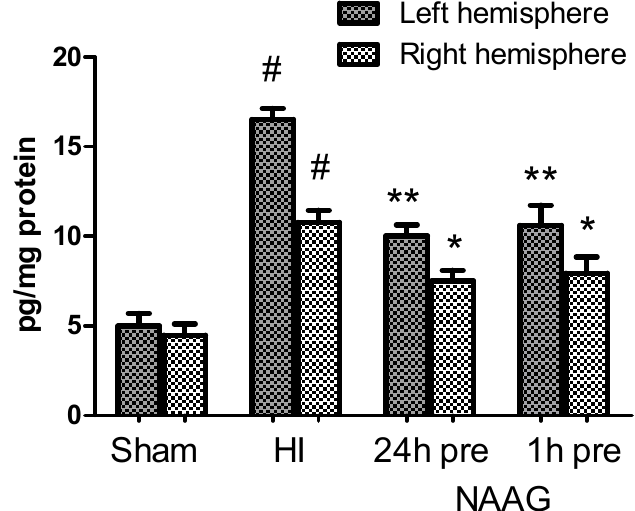
Figure 8. E ff ect of NAAG application on HI-induced changes in the TGF- β concentration. The results Figure 8. Effect of NAAG application on HI ‐ induced changes in the TGF ‐β concentration. The results are presented as the means ± SEM, n = 6; statistically significant di ff erences: * p < 0.05, ** p < 0.001 are presented as the means ±SEM, n = 6; statistically significant differences: * p < 0.05, ** p < 0.001 compared to the HI group; # p < 0.001 compared to the sham operated compared to the HI group; # p < 0.001 compared to the sham operated group.